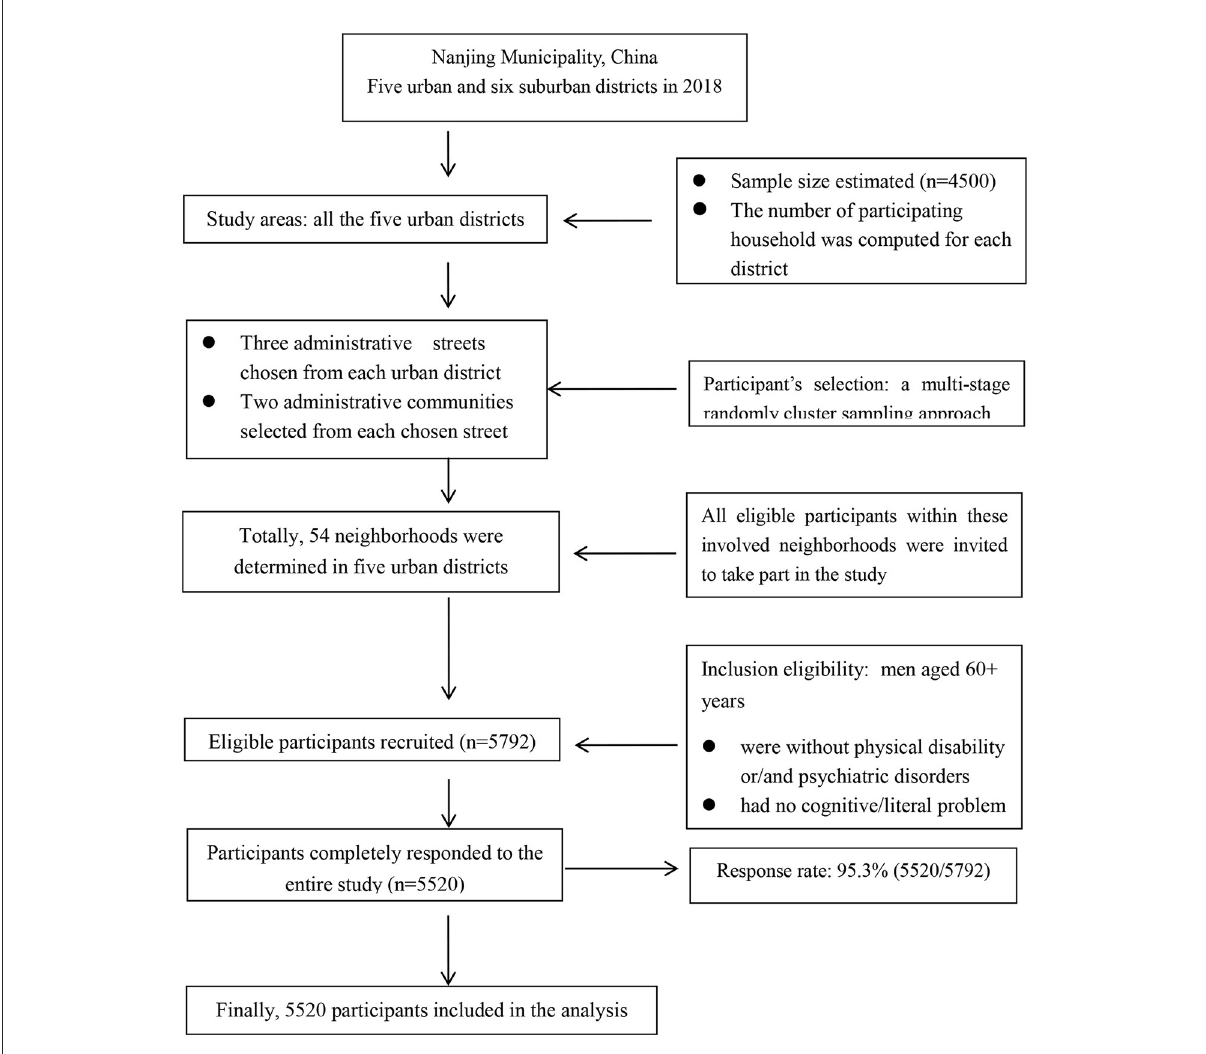
FIGURE1 Flow chart of participant’s selection in the